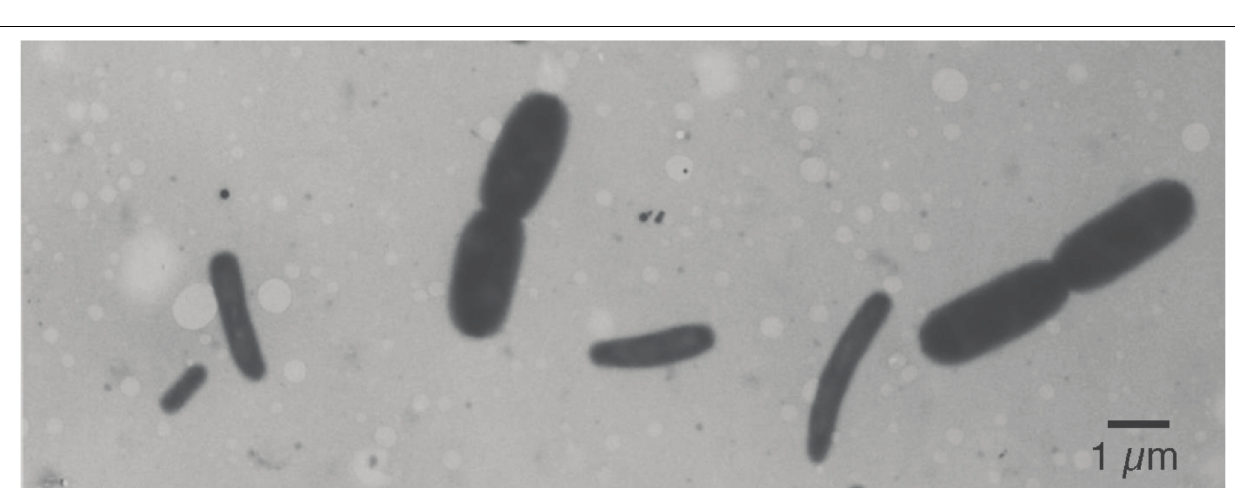
synthetic alanine-medium with a doubling time of 150 min. Compare with a similar preparation of mixed populations in Figure 2 of Nanninga and Woldringh